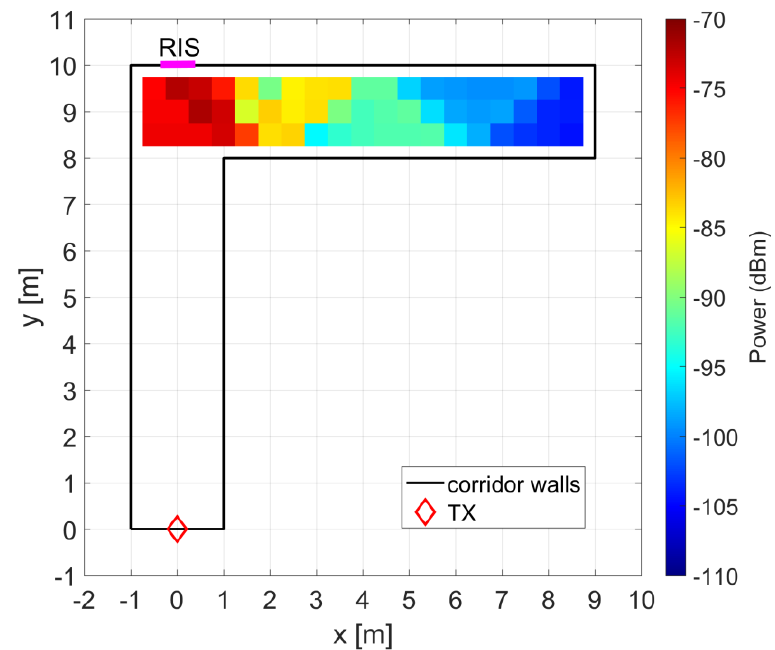
Figure 4. Coverage map in the L − shaped corridor using an RIS reflecting at 40°.